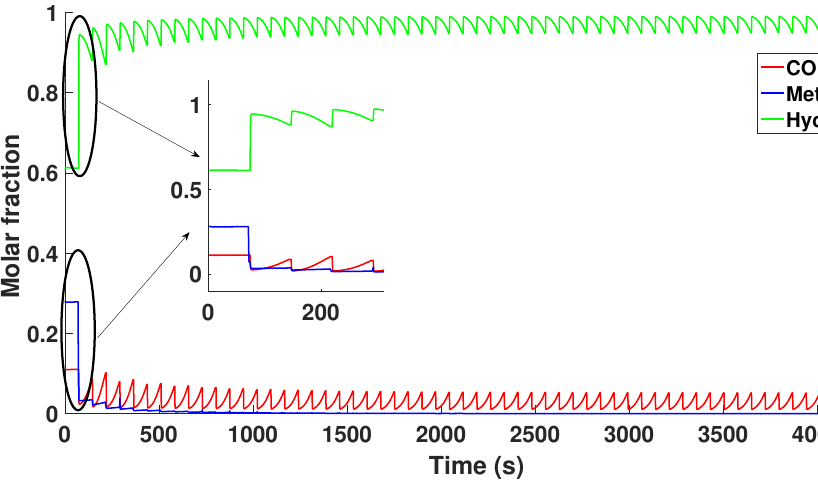
Figure 2. Purity of the CO, methane, and hydrogen obtained from the start-up of the PSA process until reaching the CSS.